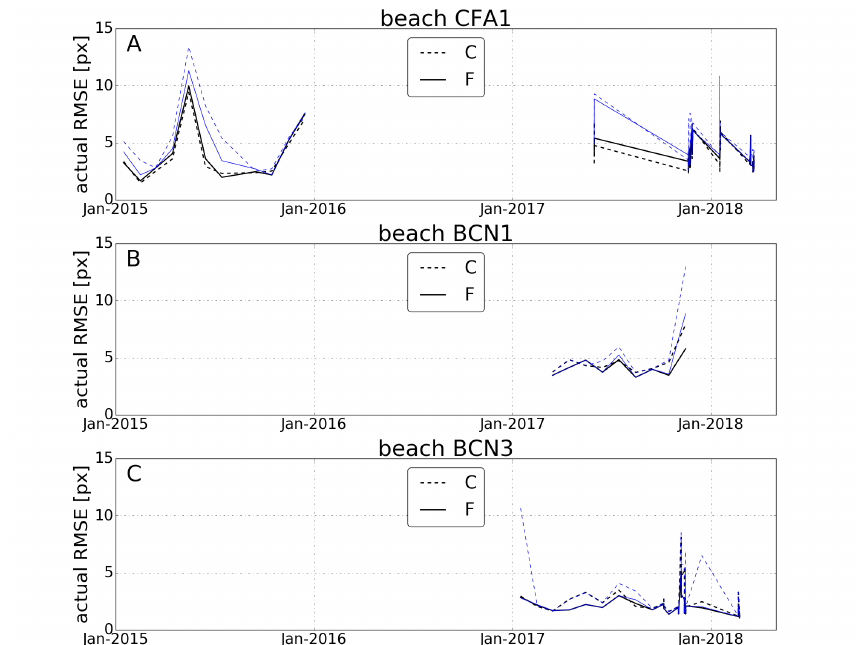
Figure 11. Actual RMSE in pixels (2 px = 1 m) of the automatic shorelines in the different dates of beaches ( A ) CFA1, ( B ) BCN1 and ( C ) BCN3, for the combined (dashed) and filtered (solid) shorelines, using a threshold of 20 px (black) or no threshold (blue) in the self-computed